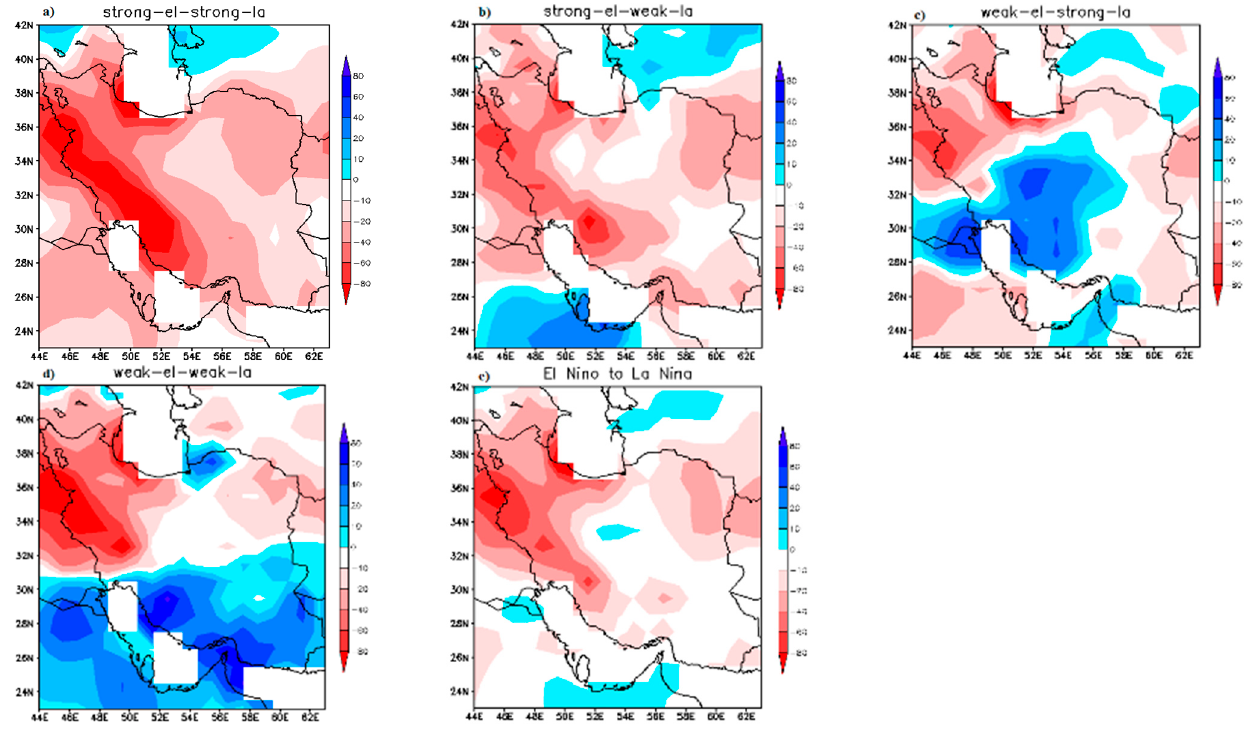
Figure 7. Autumn precipitation anomaly for type 1 transition years. Positive (or alternately, negative) anomaly is marked in blue (red). Panels ( a – d ) show patterns for different subtypes, while panel ( e ) shows the average over all the type 1 cases.